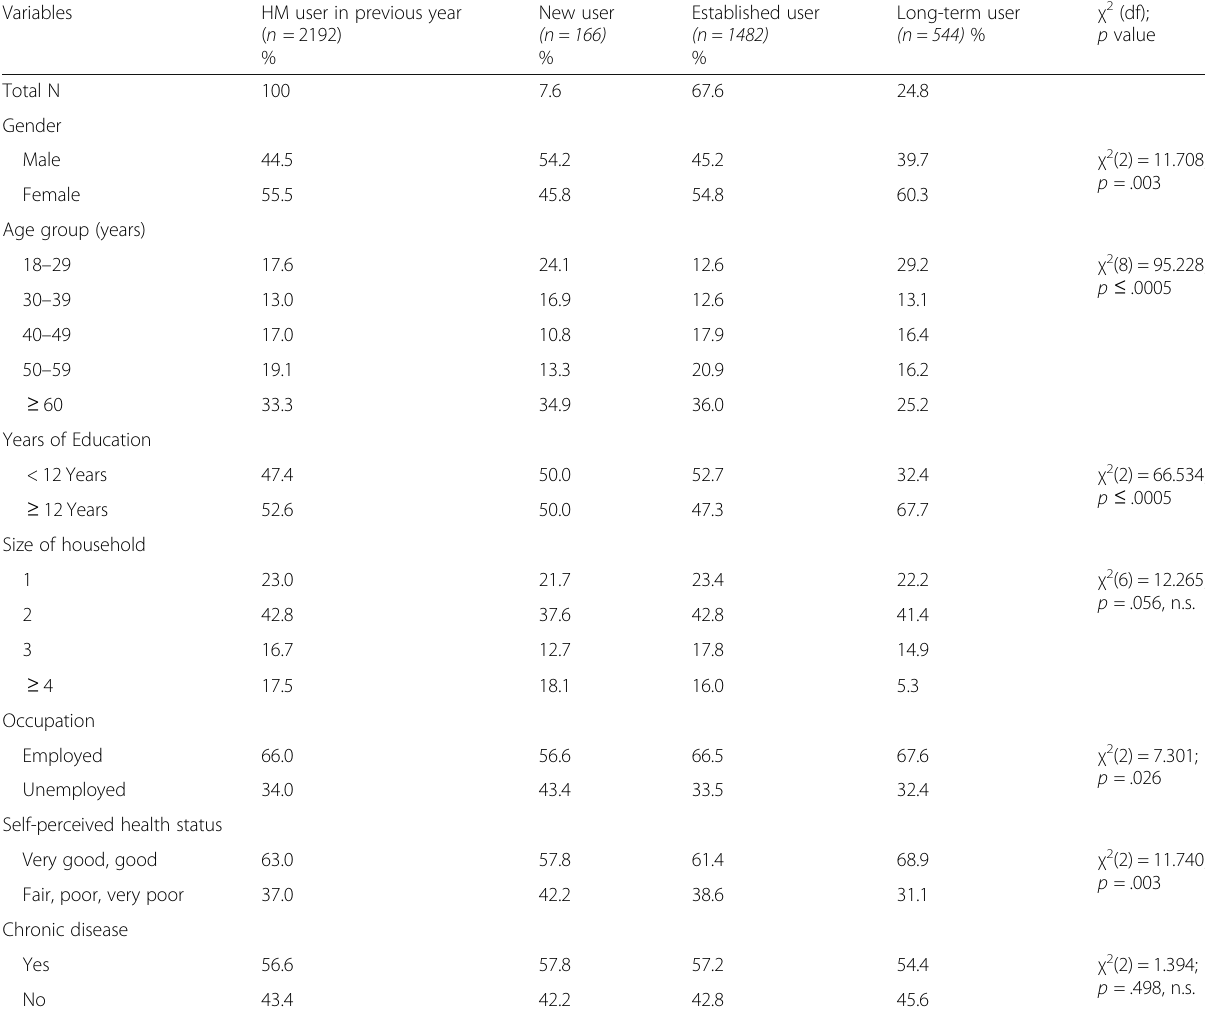
Table 1 User characteristics of the overall HM users in the previous year and the three user subgroups and results of Chi-Square tests for a subgroup comparison